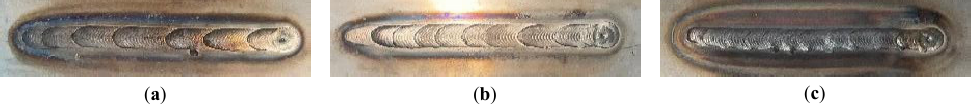
Figure 9. WAAM experiment for dripping frequency under different wire feed speeds: ( a ) wire feed speed of 0.5 cm/s, ( b ) wire feed speed of 0.67 cm/s, ( c ) wire feed speed of 0.83 cm/s. Table 4. Comparison of droplet number and dripping frequency between experimental data and theoretical